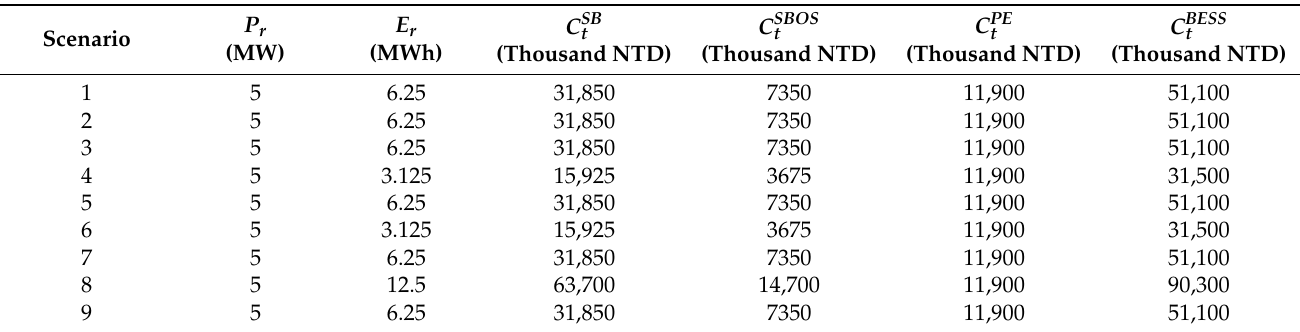
Table 5. Establishment cost estimation of each